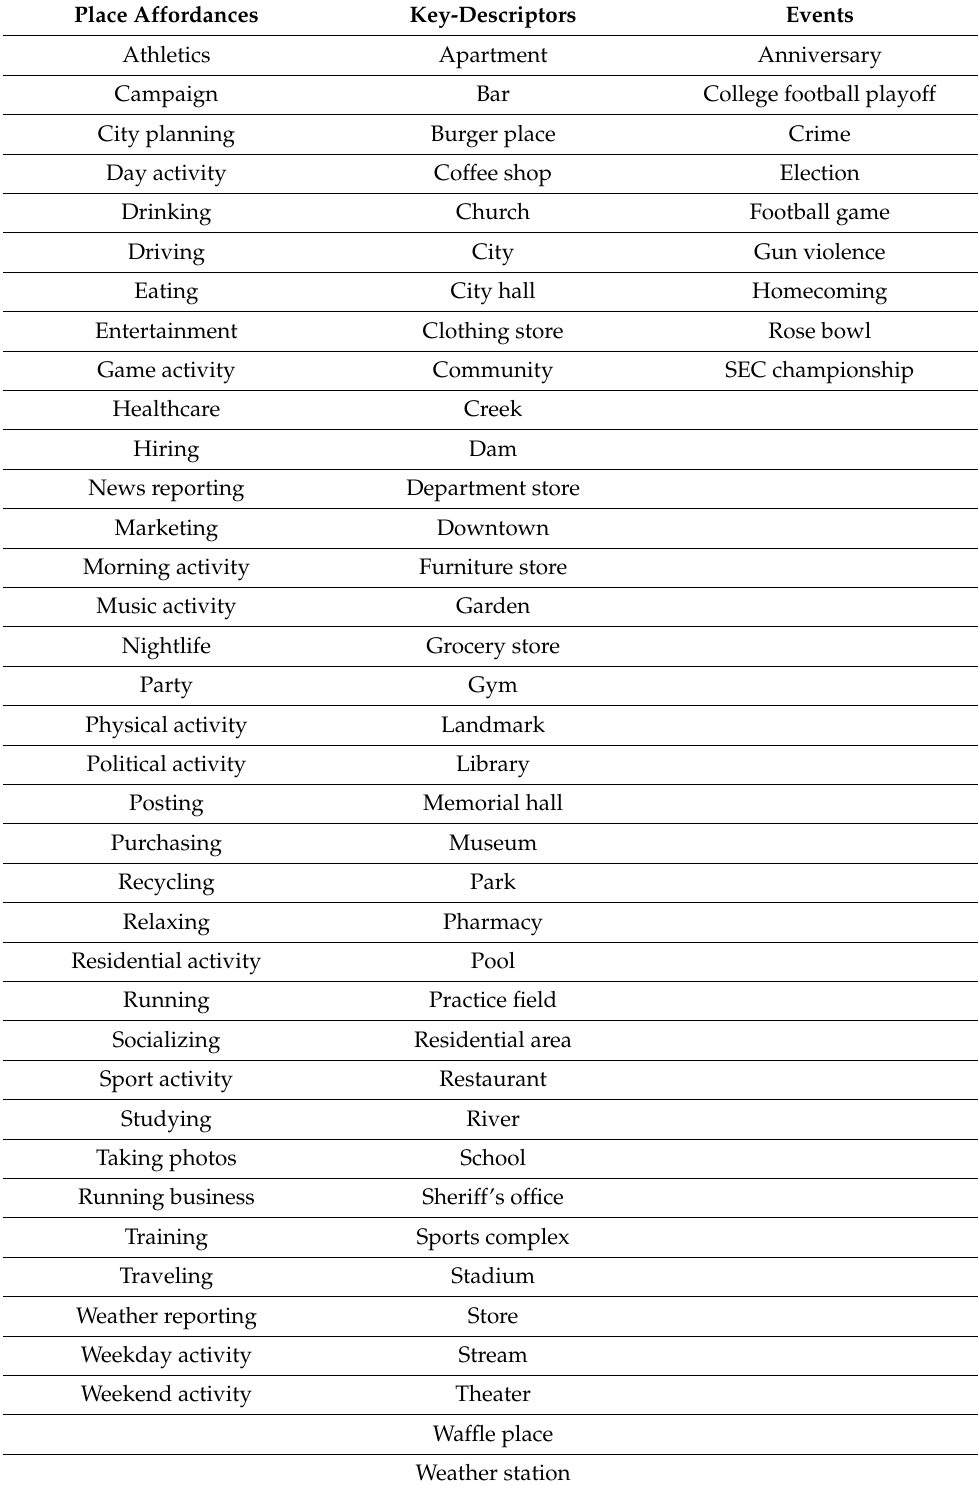
Table 3. Candidate elements in the component functional signatures (identified from Twitter